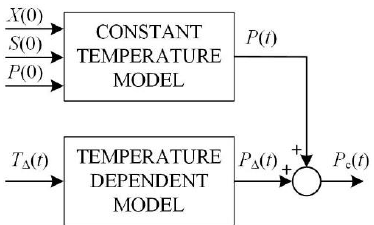
Figure 1. Block diagram of the complete mathematical model that takes into consideration the impact of temperature on the fermentation process in the batch bioreactor. of temperature on the fermentation process in the batch bioreactor.